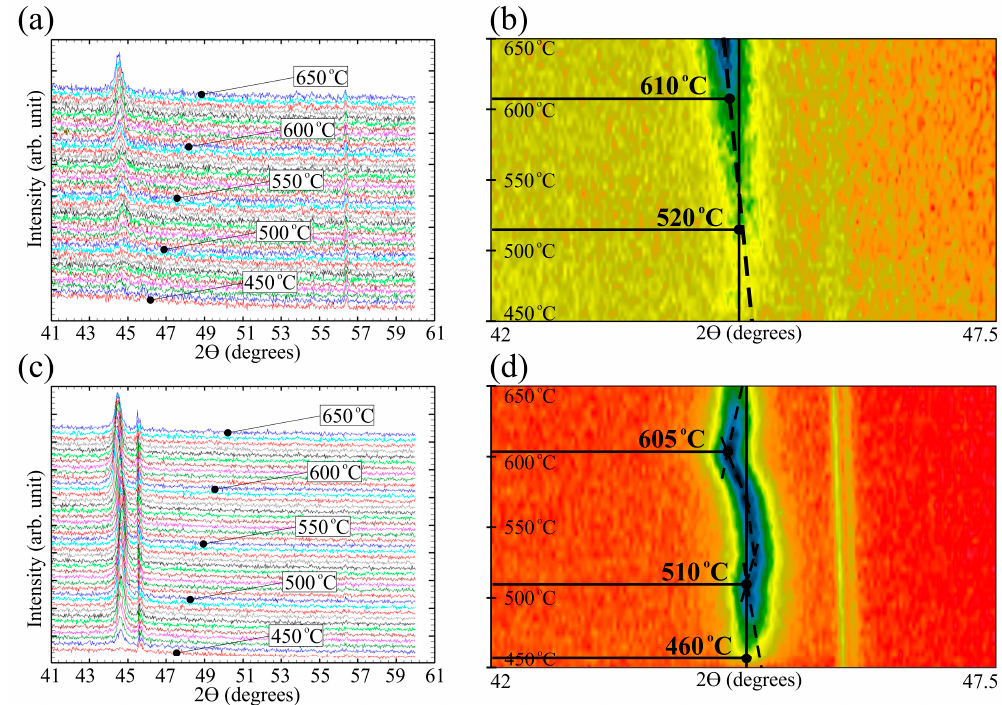
Figure 3. Temperature X-ray diffraction (TDX) data of Fe 72.5 Nb 1.5 Mo 2 Cu 1.1 Si 14.2 B 8.7 films with thicknesses of 100 ( a , b ) and 200 nm ( c , d ). XRD patterns at the temperature interval 450–650 ° С , step–5 ° С ( a , c ). View from above on the XRD patterns ( b , d ).